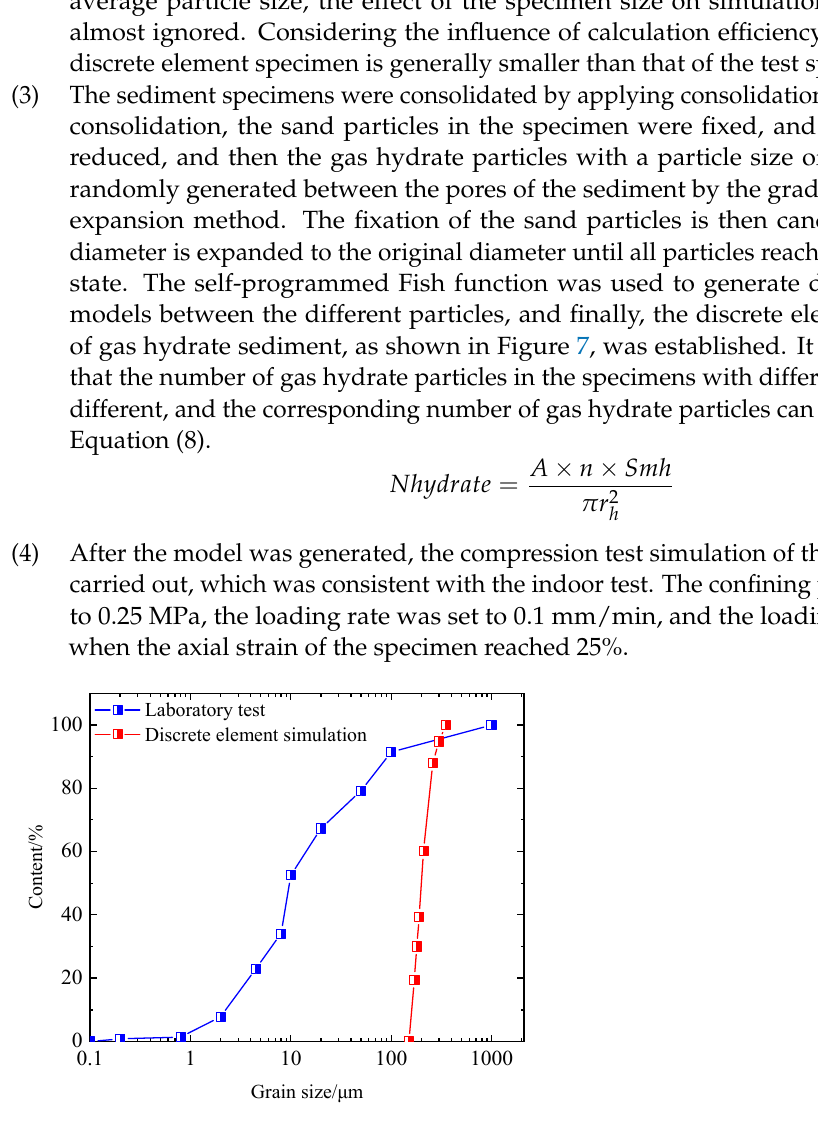
Figure 6. Gradation curves for gas hydrate deposits in experiments and discrete element simulations. (Adapted with permission from Ref. [37]. 2021, Wu, D.J).